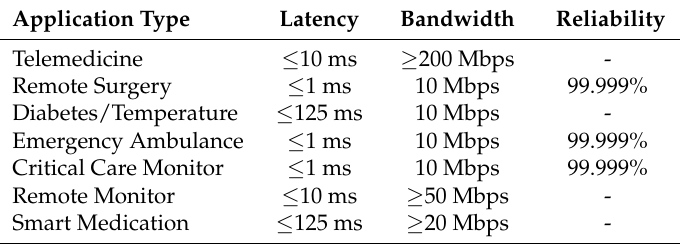
Table 2. S-Health and performance requirements.